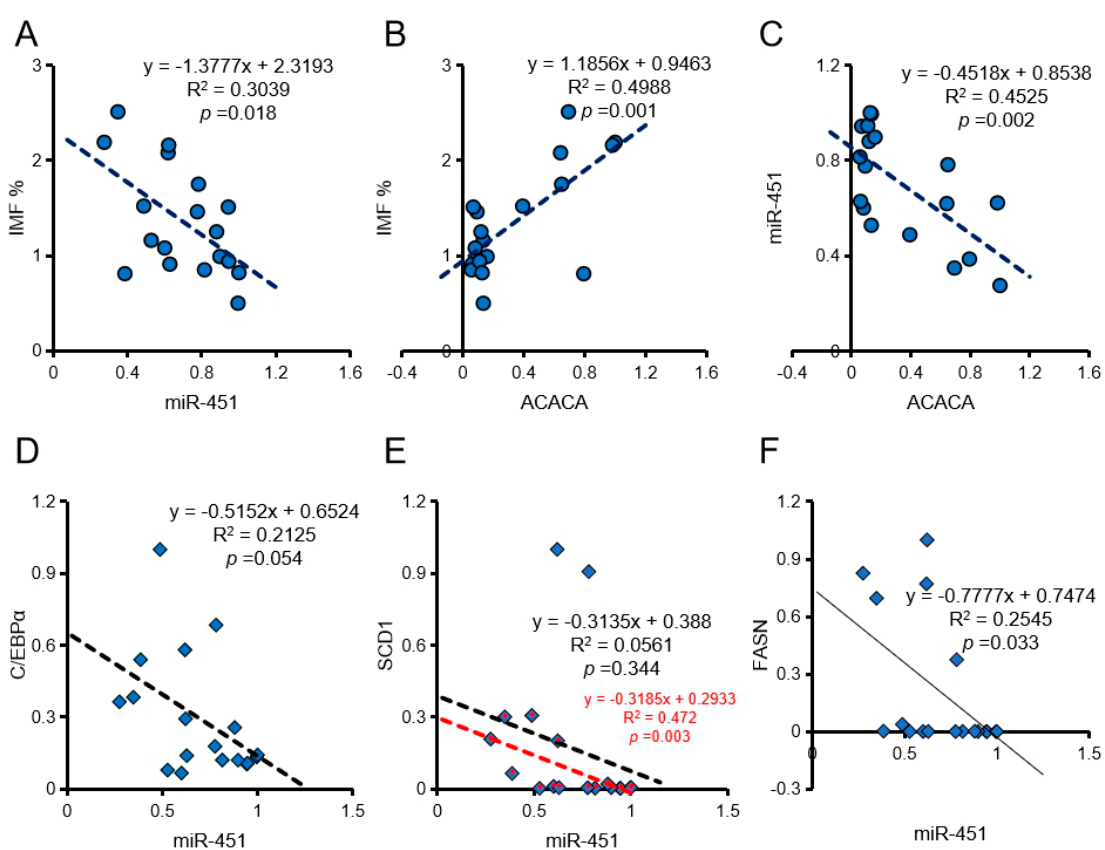
Figure 4. E ff ect of ssc-miR-451 on intramuscular fat content (IMF) of longissimus dorsi. ( A , B ) IMF correlates with miR-451 and ACACA expression in longissimus dorsi, n = 18. ( C ) The expression of miR-451 correlates with ACACA in pork, n = 18. ( D ) The expression of miR-451 correlates with C / EBP α in pork, n = 18. ( E ) The expression of miR-451 correlates withSCD1 in pork, n = 18. The red mark is the correlation analysis after removing the discrete points, n = 16. ( F ) The expression of miR-451 correlates with FASN in pork, n = 18. The data of correlation analysis were from 18 DLY pigs (half barrows and half gilts).